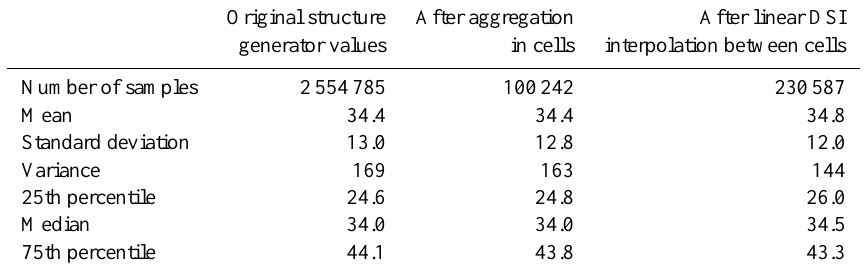
Table 6. Statistical values for the property “fine sand content” (in %) after aggregation and interpolation in GOCAD. Also see Fig. 12a–c.